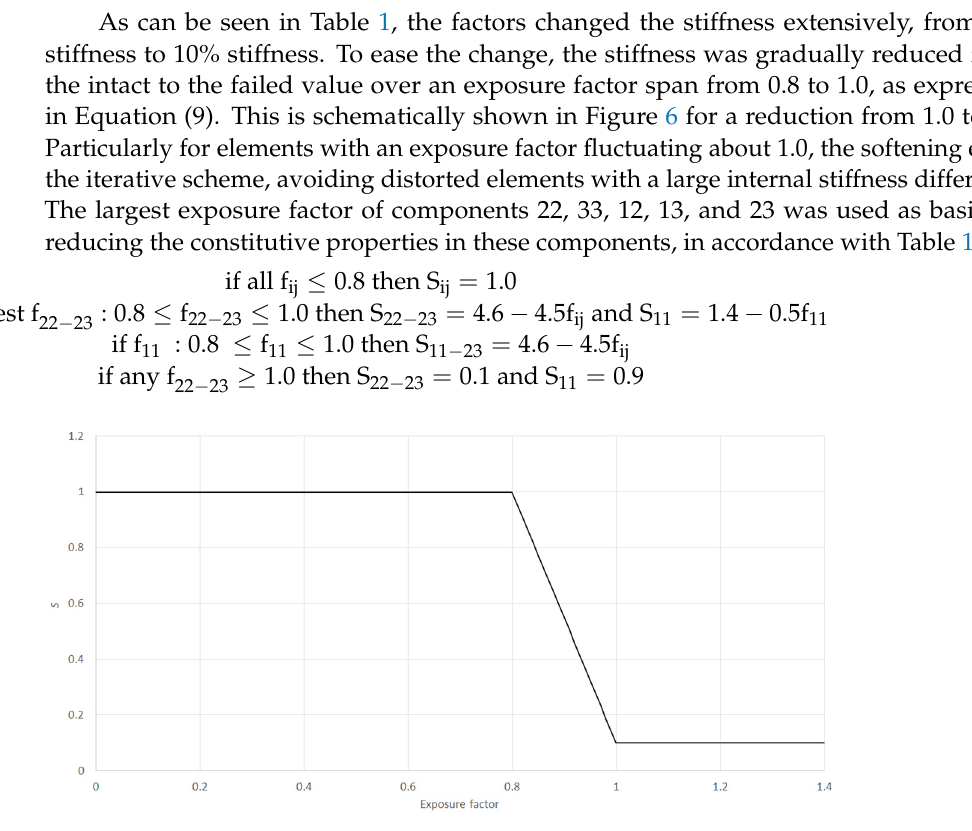
Table 1. How reduction factors are changed depending on failure criterion.